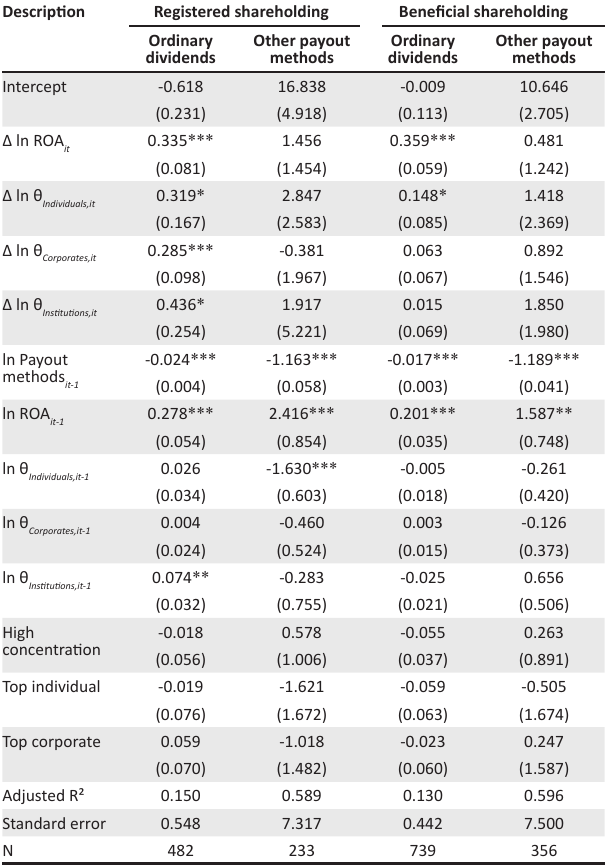
TABLE 2: Regression results – payout methods and investor tax preference parameters. Description